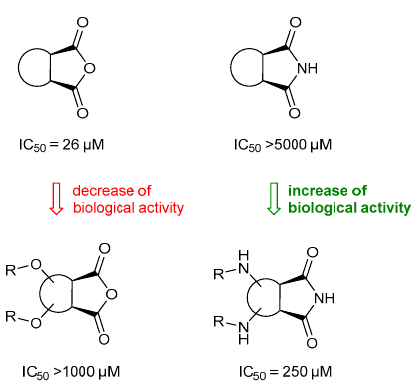
Figure 1. Increasing biological activity of cantharimide by introduction of an amino function (IC 50 in HT-29 cells is given in µM).